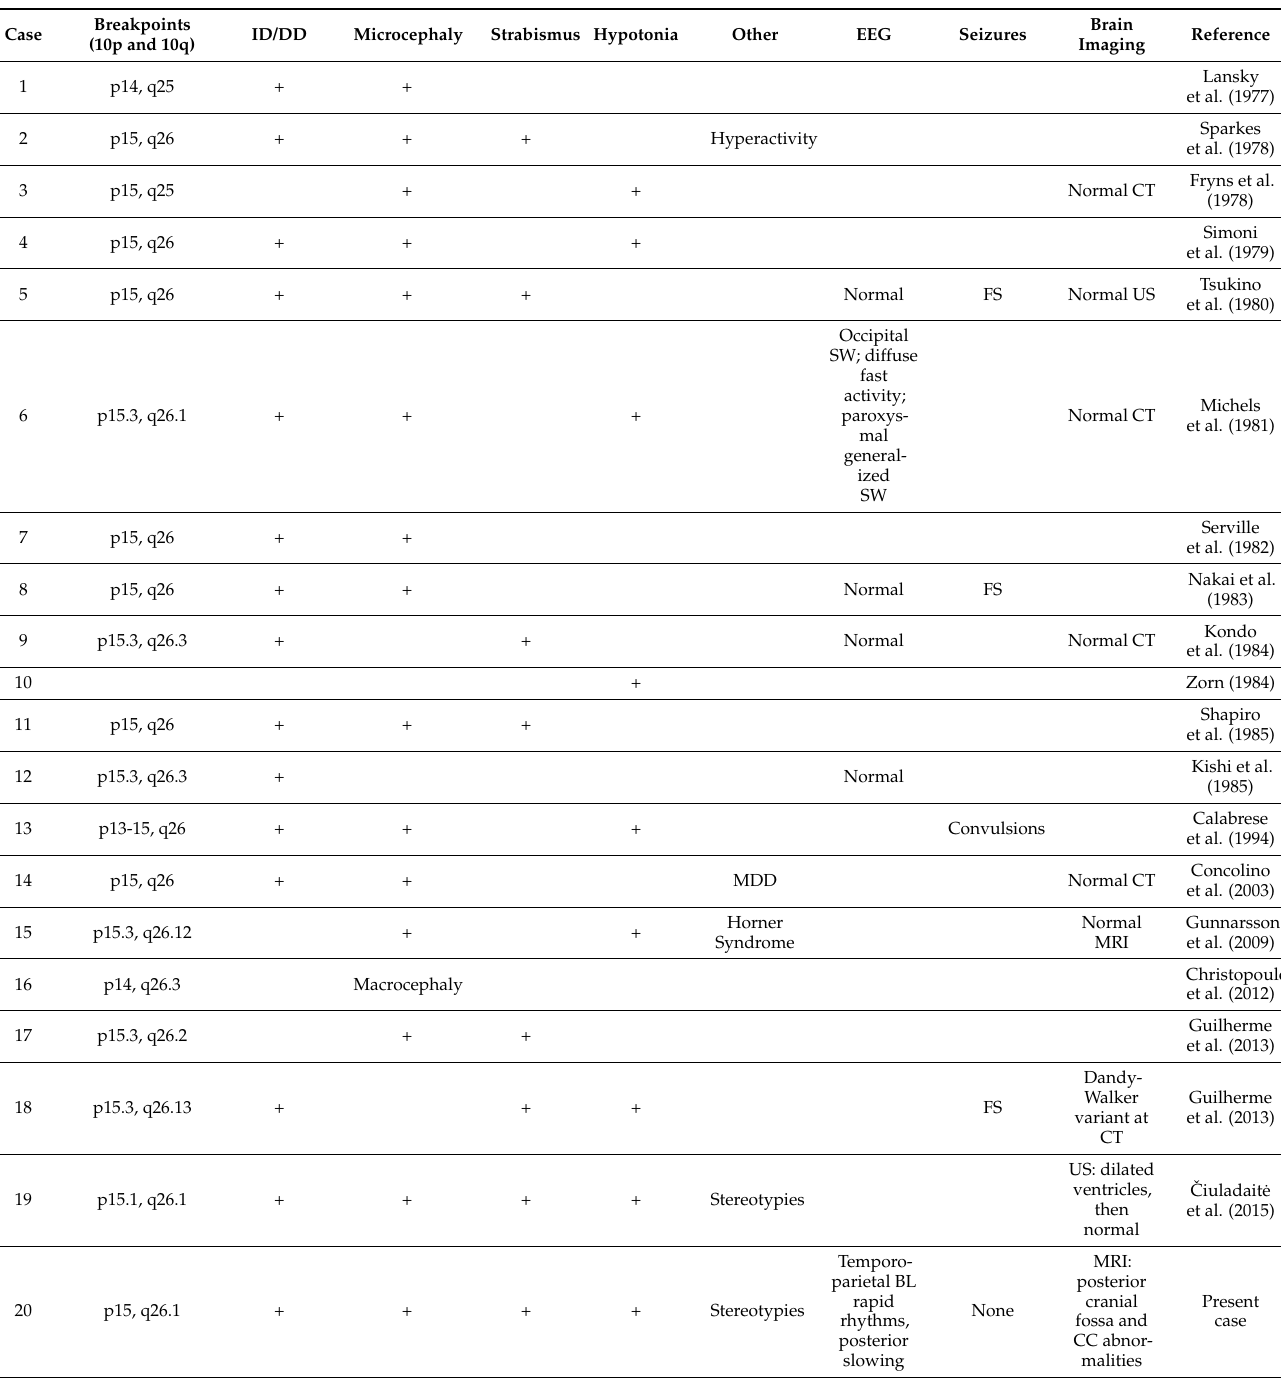
Table 2. Neurological phenotype of described patients with ring 10 chromosome